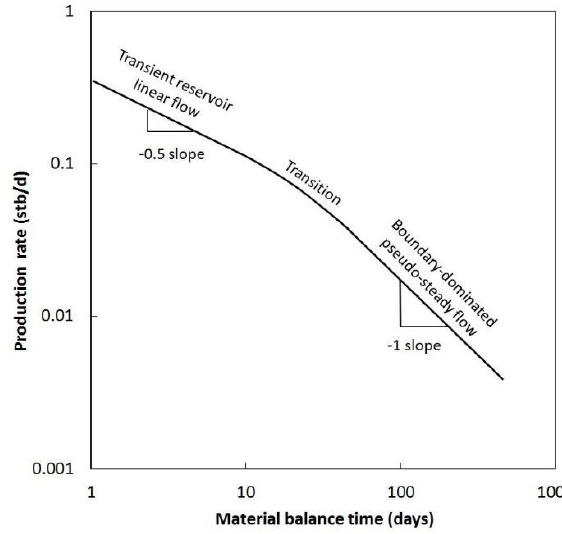
Figure 3. Diagnostic plot of rate transient data for flow regime identification.